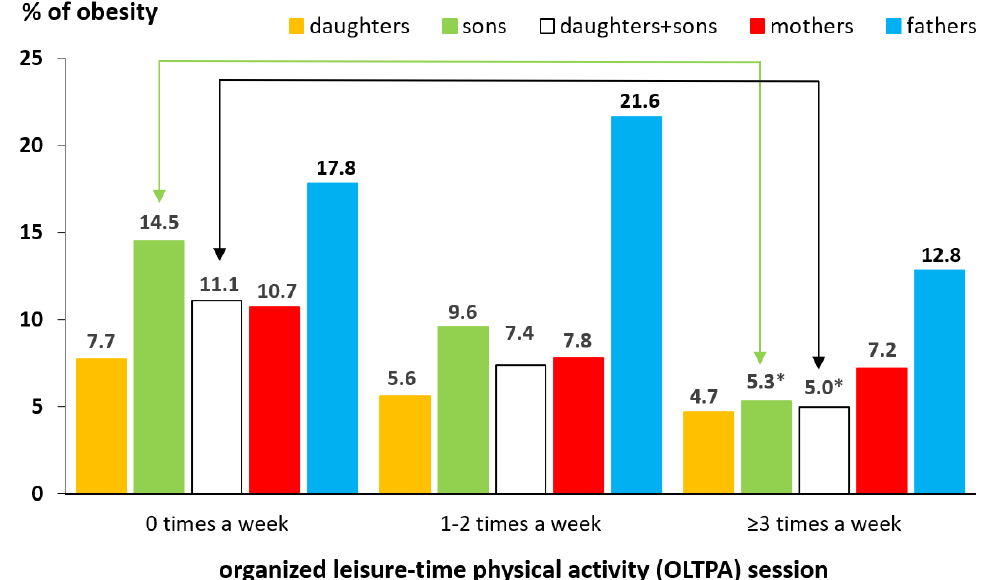
Figure 2. The prevalence of obesity of family members separated according to the frequency of organized leisure-time physical activity of the offspring (* statistically significant differences between participation 0 and ≥ 3 times a week in organized leisure-time physical activity based on the Chi-square tests, p < 0.005 ).